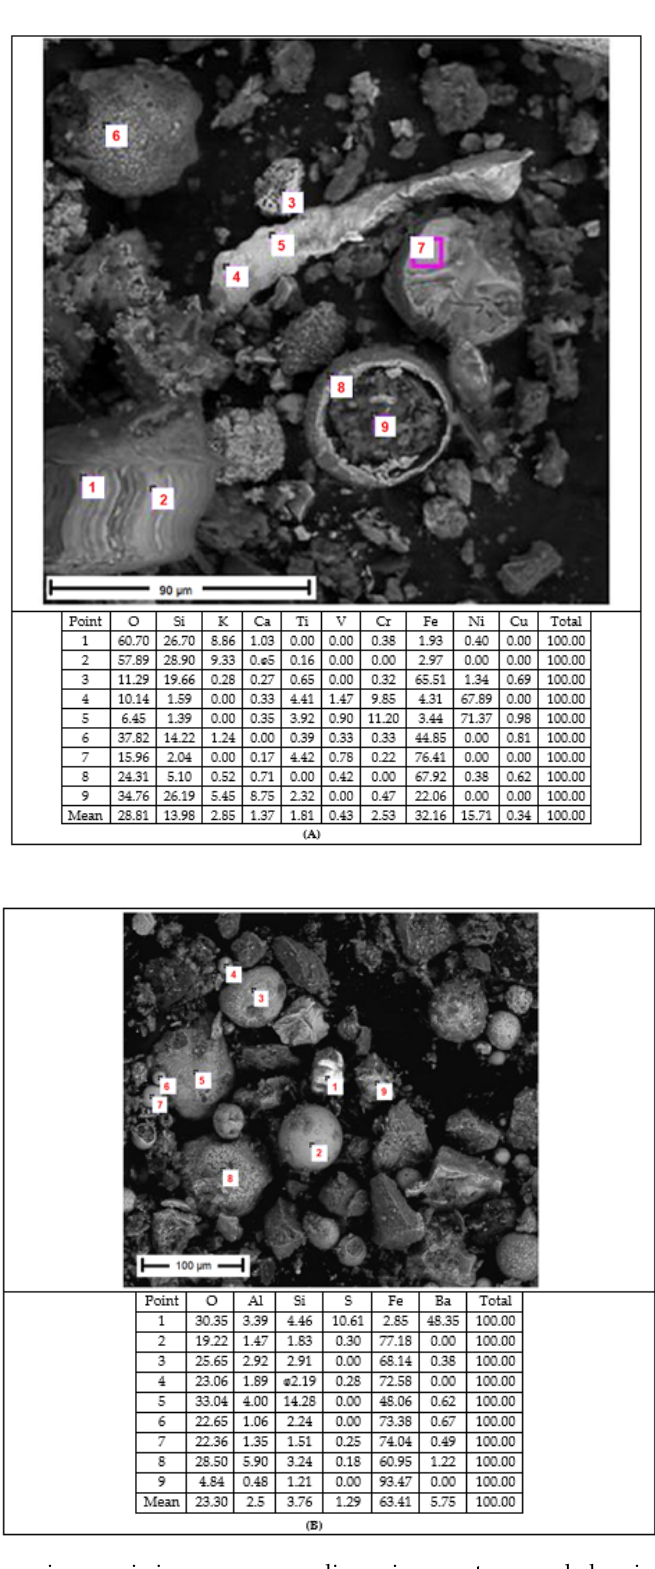
Figure 5. Electron microscopic images, energy dispersive spectrum and chemical composition of particles of the magnetic phase of soils in the city of Gubakha (layer 0–10 cm): ( A ) residential zone; ( B ) industrial zone of OAO “Gubakhinsky